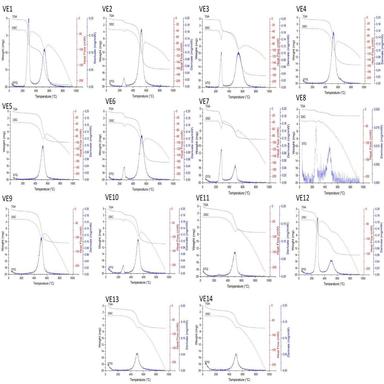
Thermal analysis, including DSC, TGA and DTG curves of the samples.